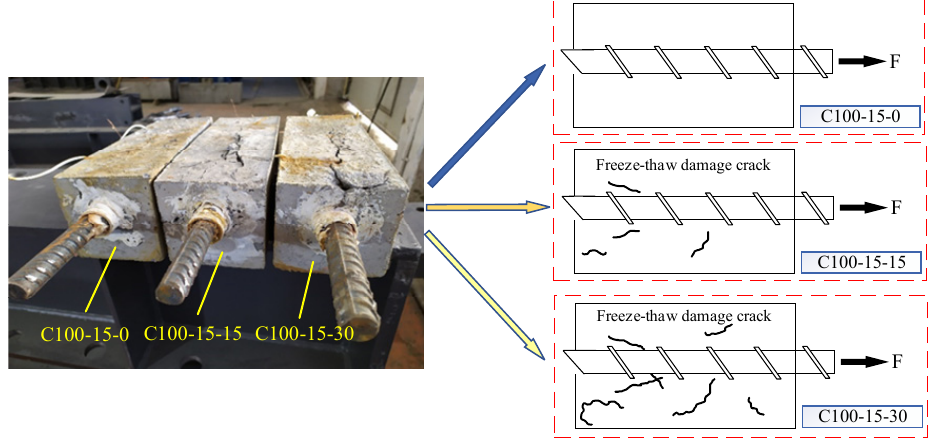
Figure 9. Micro-cracks near steel bars in concrete.